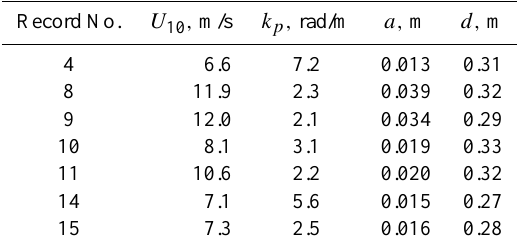
Table 2. Summary of AUSWEX data. U 10 is the wind speed at 10m height, k p is the peak wave number, a is the standard deviation wave amplitude, d is the water